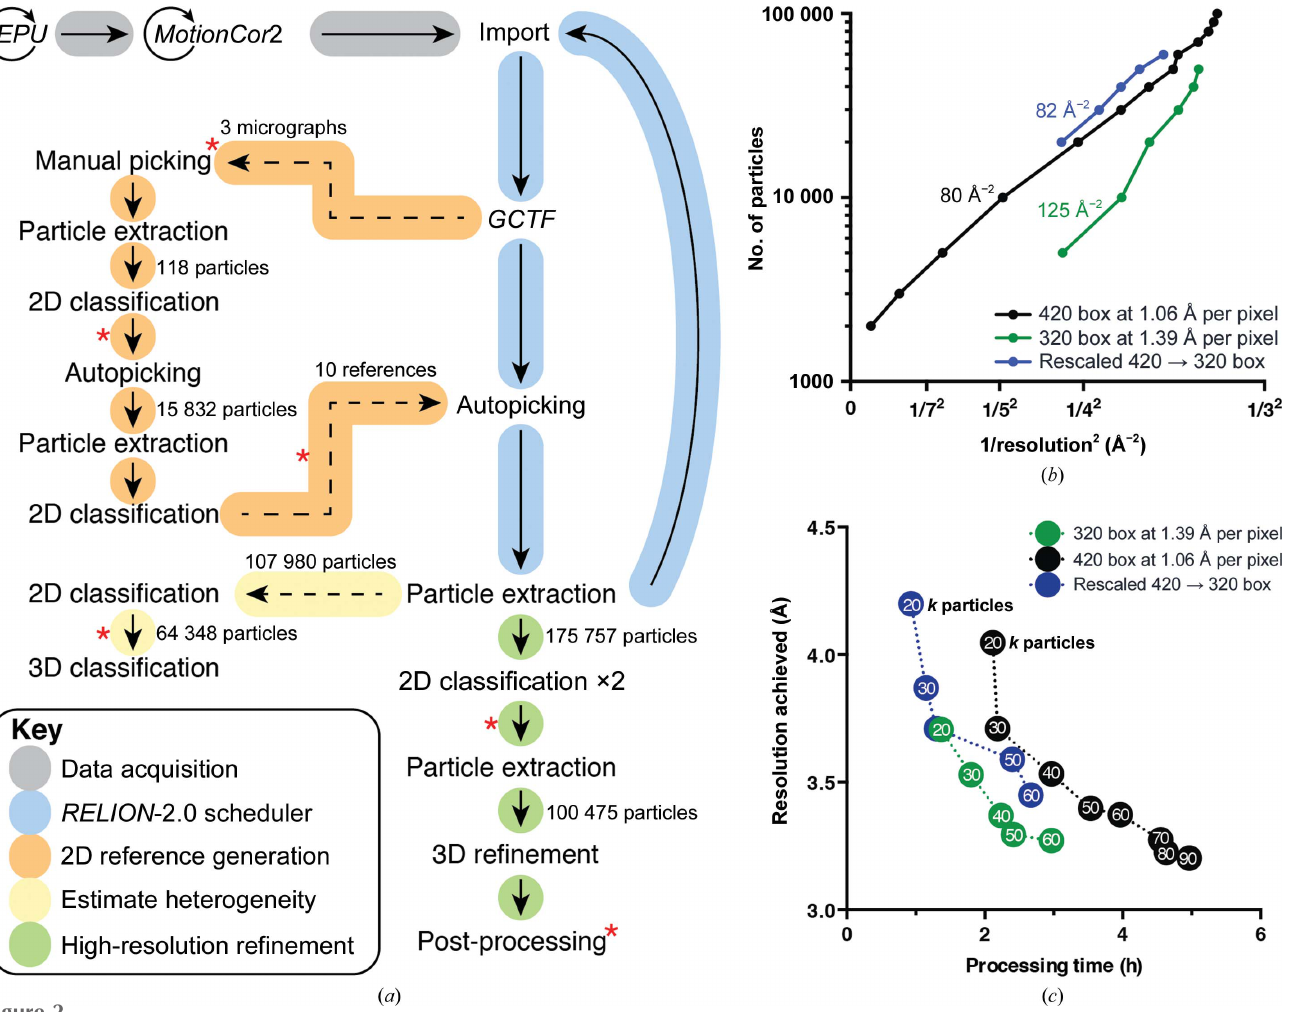
Figure 2 Data-processing workflow and correlation between data-collection parameters, processing time and resolution. ( a ) Data-processing workflow. ( b , c ) Effect of particle number and processing time on attained resolution at magnifications corresponding to 1.06 and 1.39 A˚ per pixel. Steps in which manual intervention is presently required are marked by red asterisks. Note, however, that the scheduling cycle does not rely on any such